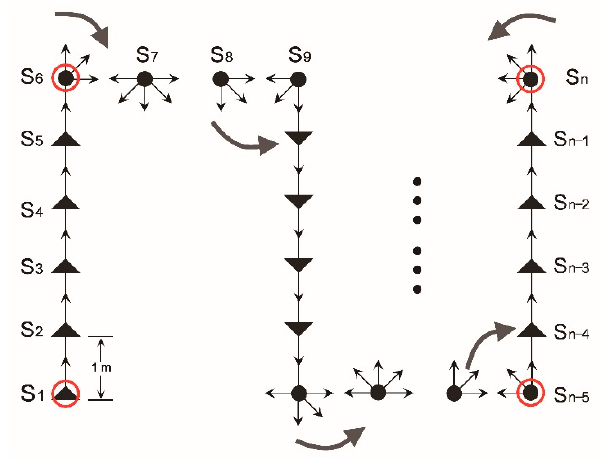
Figure 5. Terrestrial continuous photogrammetry route. The site marked with red indicates two points to be noted: one point is that the coordinates of the site are collected accurately and the other point is that the route to the site ensures the continuity of the captured image.